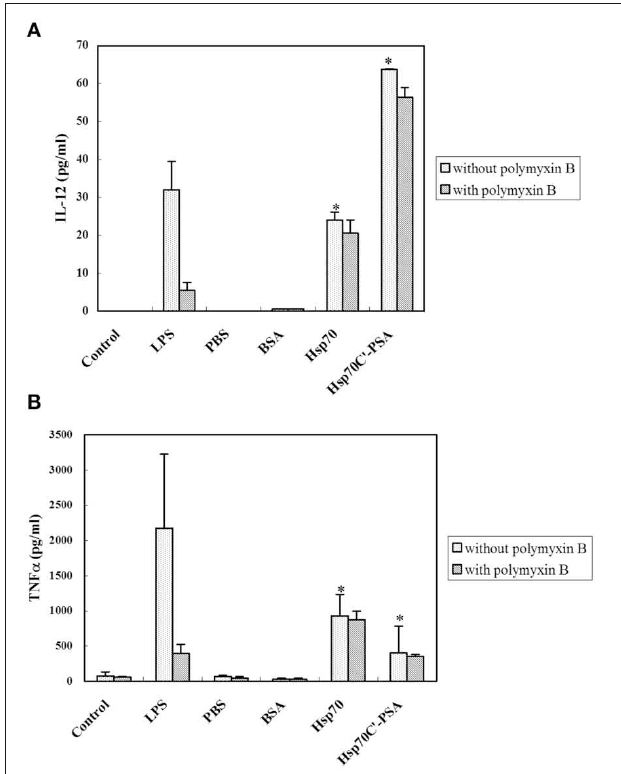
FIGURE 2 | Exogenous rHSPs enhance the expression of pro-inflammatory cytokines. BM-DCs (1 . 5 × 10 6 in 1ml) were incubated with medium alone (control) or LPS (10 μ g/ml) or were cocultured at 37 ◦ C for 24h with irradiated-CT26/PSA cells (1 . 5 × 10 6 in 1ml) of PBS or 10 μ g/ml of BSA, rHsp70, or rHsp70C (cid:2) -PSA in the absence or presence of 10 μ g/ml of polymyxin B. The supernatants were then harvested and the concentration of IL-12 (A) or TNF- α (B) measured by ELISA. The data are the mean ± SD for three-independent experiments. ∗ Indicates p < 0 . 05.